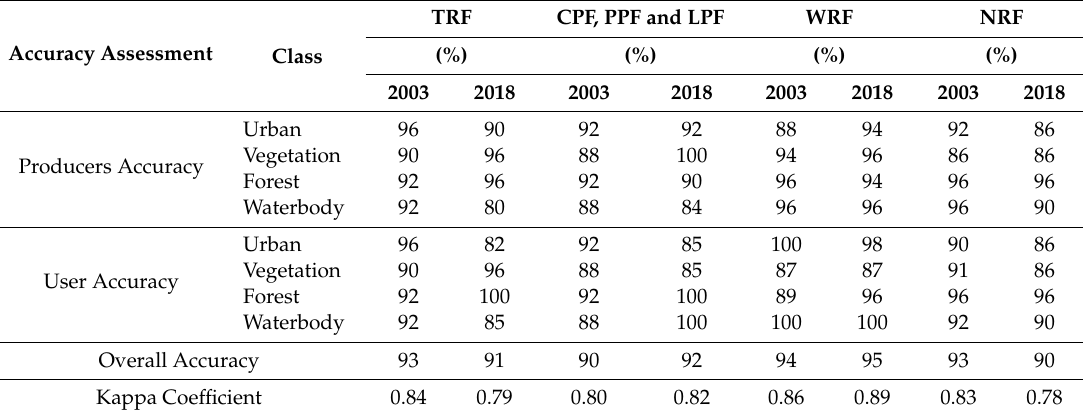
Table 8. Accuracy assessments for LULC in 2003 and